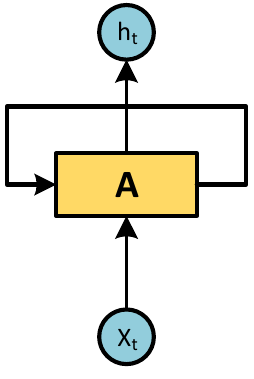
Figure 2. NARNN have loops.